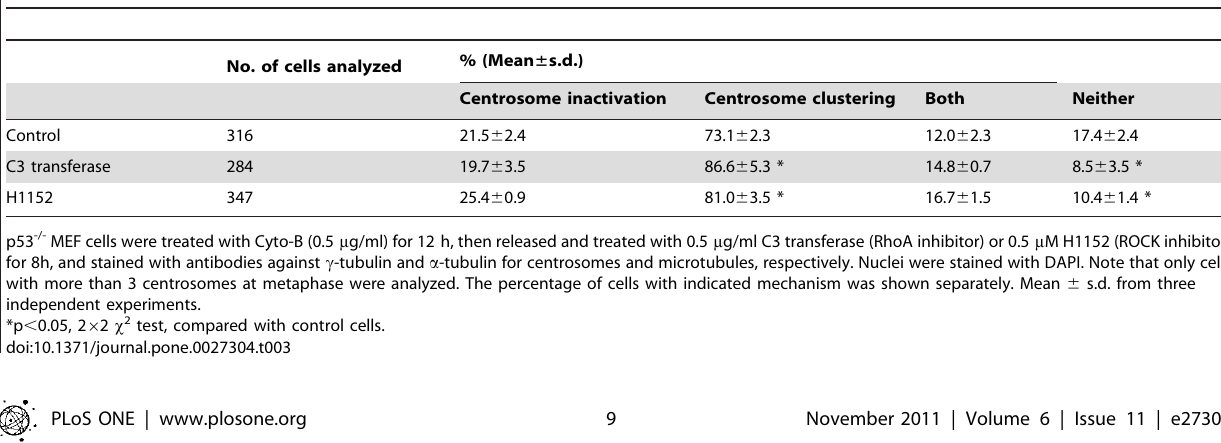
Table 3. Centrosome clustering was enhanced in p53 -/- MEF cells with extra centrosomes after RhoA or ROCK inhibition.